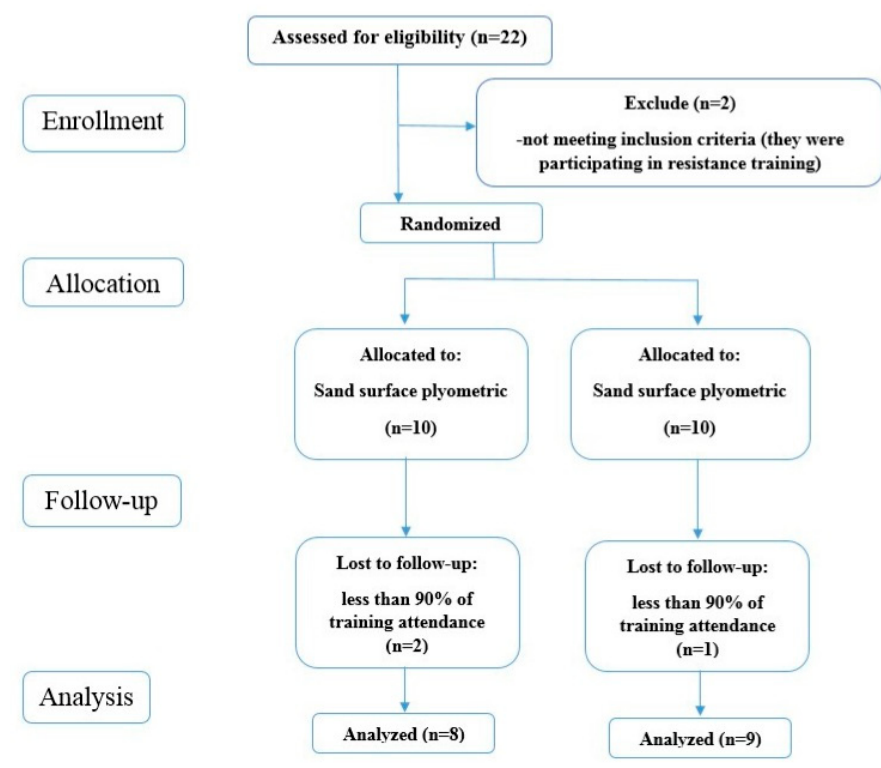
Figure 1. CONSORT diagram of participants’ recruitment, allocation, follow-up and.